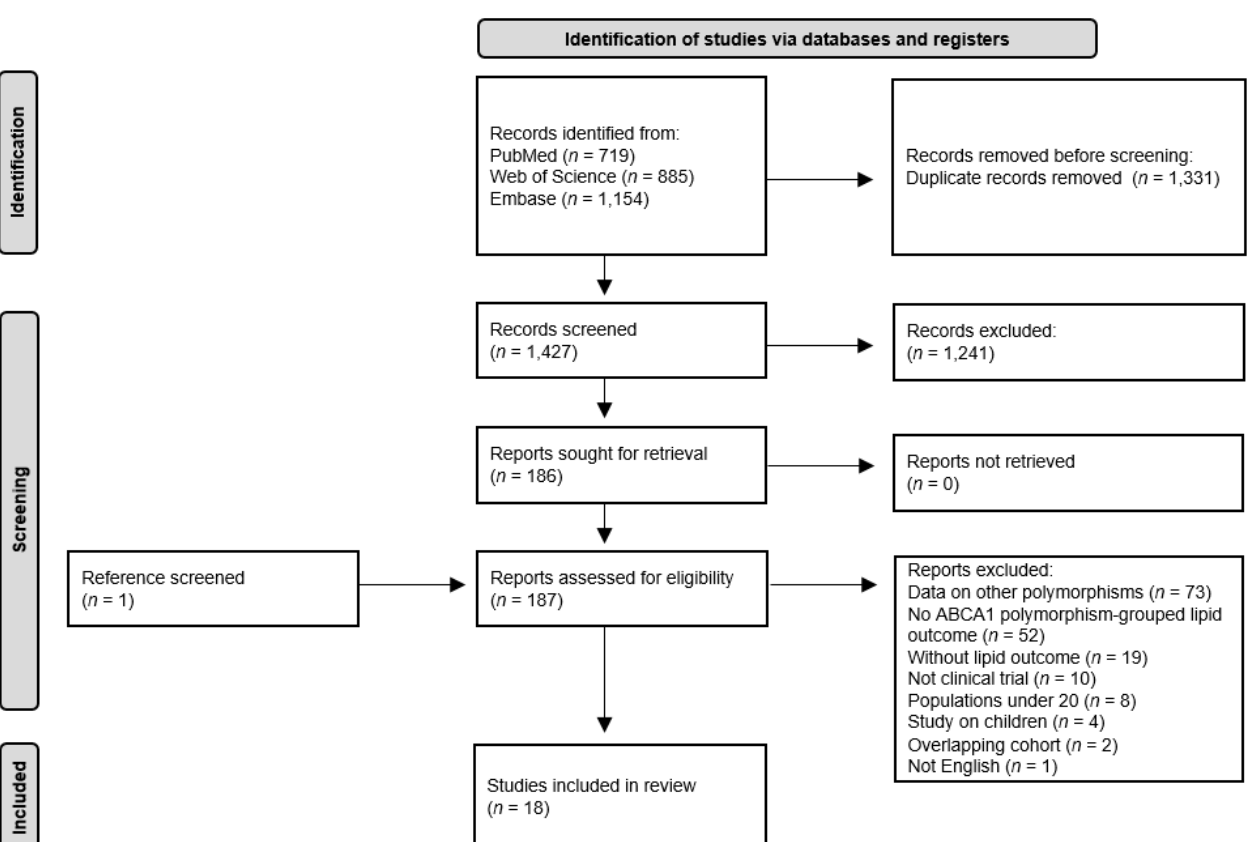
Figure 1. Flow diagram of study inclusion.